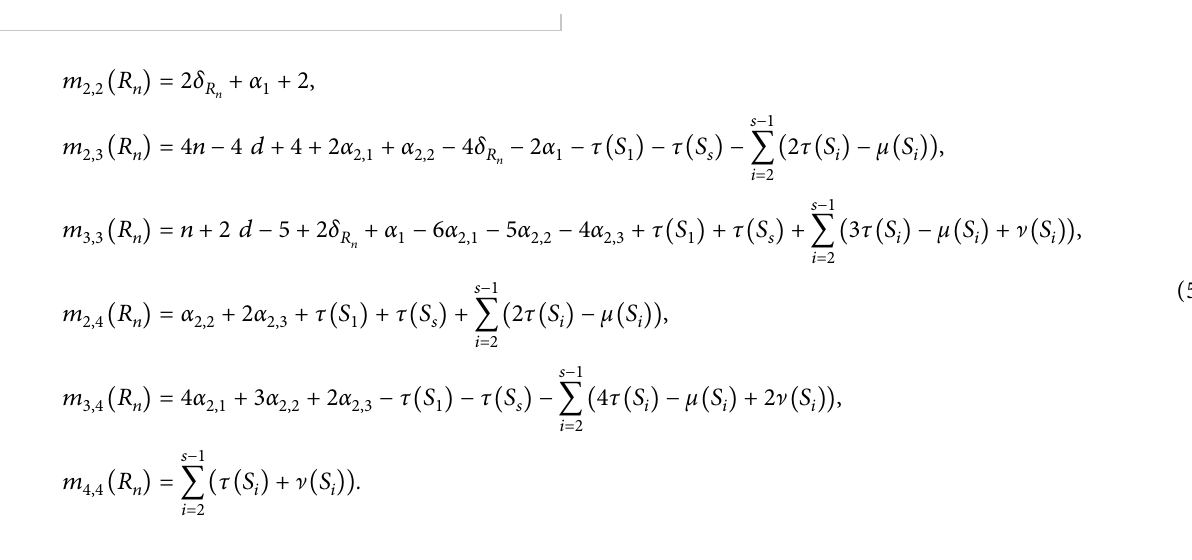
Figure 4: Internal segment of length three containing an edge connecting vertices of degree 3.